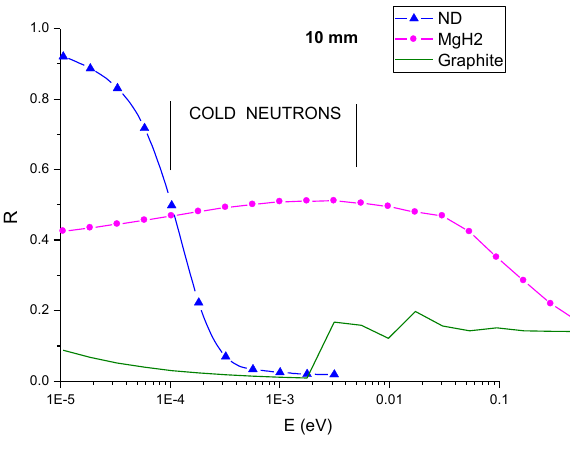
Fig.11 : Reflectivity profile of MgH 2 . Comparative with known moderators/reflectors shows constant performance for a wide energy range.